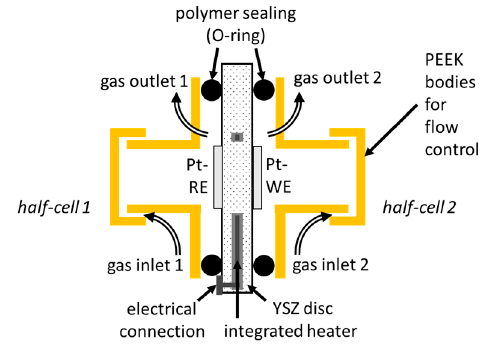
Figure 2. Scheme of the sensor setup to compare electrochemically two gas